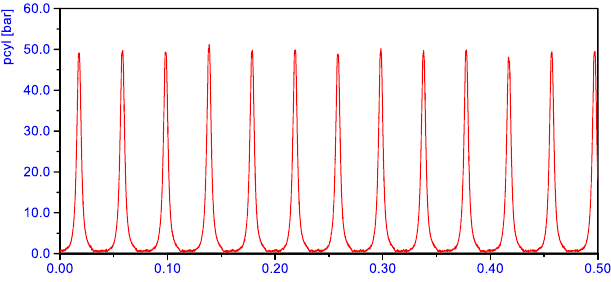
Fig. 6. Fragment of the pressure in the first cylinder – operating point No. 2